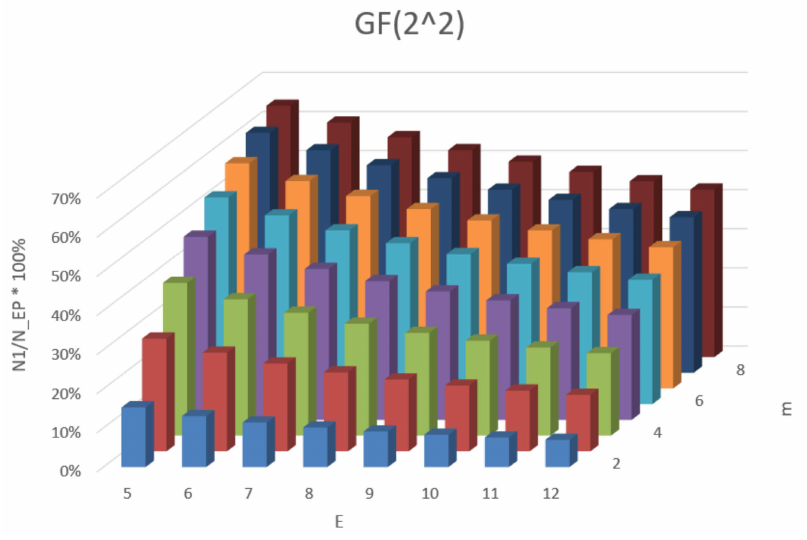
Figure 3. Contribution to the total complexity estimate N EP for a group of polynomials over GF ( 2 2 ) .